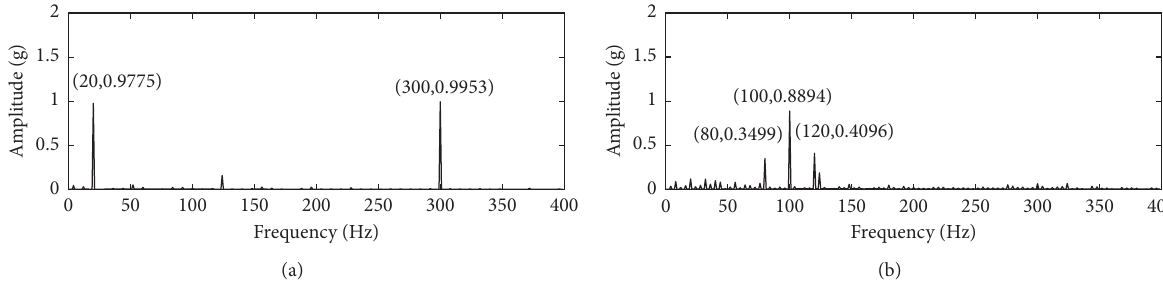
Figure 7: Vector LCD spectra of simulation signals: (a) normal condition; (b) abnormal condition.